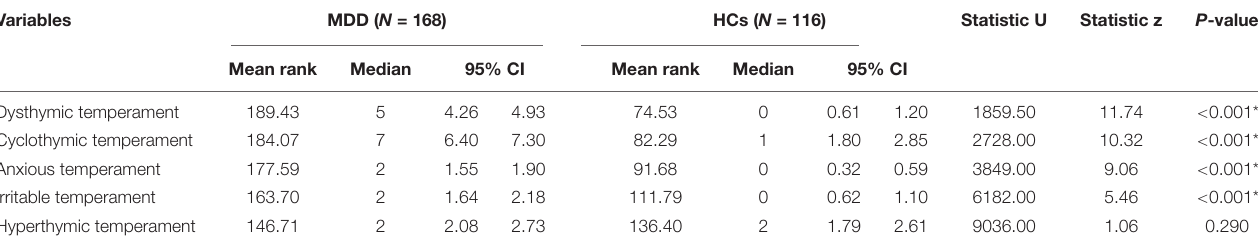
TABLE 2 | Comparisons of the temperament evaluation of the Memphis, Pisa, Paris, and San Diego Auto-questionnaire (TEMPS-A) between MDD and HCs.